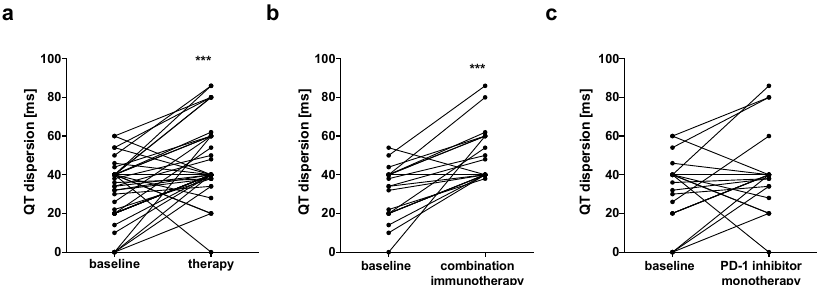
Figure 2. QT dispersion (QTd) increased after therapy start ( a ) QT dispersion in the whole study group increased after start of therapy. Subgroup analyses showed that QTd only increased in ( b ) patients that received combination immunotherapy ( n = 21), but not in ( c ) patients receiving anti–programmed death 1 (PD-1) inhibitor monotherapy ( n = 20). *** p < 0.001.